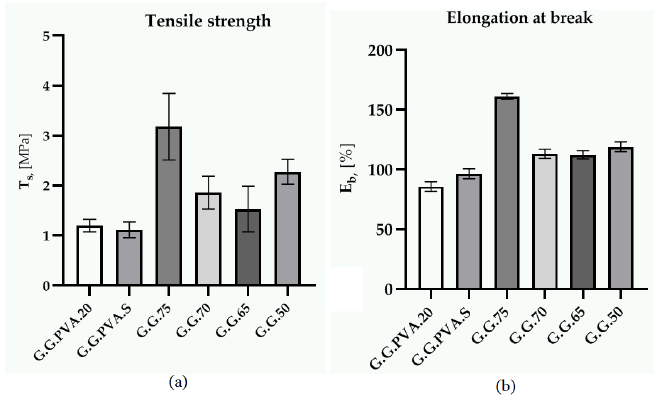
Figure 4. Tensile strength ( a ) and elongation at break ( b ).